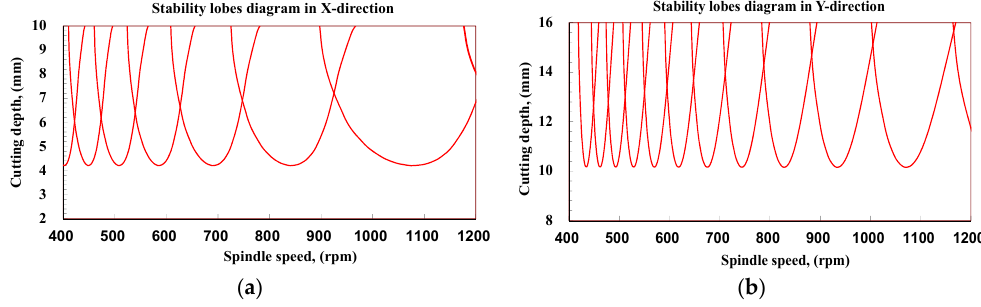
Figure 9. Predicted stability lobe diagrams in X and Y directions based on the vibration mode associated with the machine tool structure. ( a ) Stability lobes in X direction, ( b ) Stability lobes in Y direction.